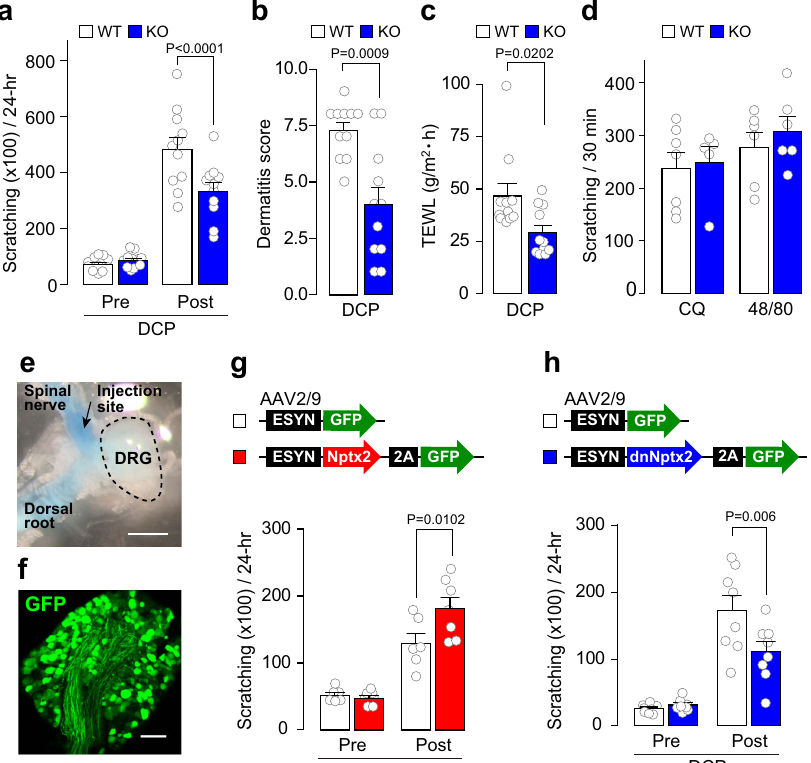
Fig. 4 Role of NPTX2 in chronic itch-like behavior. a Scratching behavior for 24 hr in WT and NPTX2 KO mice before (Pre) and after DCP treatment (Post) ( n = 11 mice/group; two-way repeated-measures ANOVA with post hoc Bonferroni test). b , c Dermatitis score ( c ) and transepidermal water loss (TEWL) ( d ) in DCP-treated WT and NPTX2 KO mice ( n = 11 mice/group). d Scratching bouts induced by intradermal injection of chloroquine (200 μ g) and compound 48/80 (50 μ g) in WT and NPTX2 KO mice (chloroquine: WT, n = 7; KO, n = 5; compound 48/80: WT, n = 6; KO, n = 6). e Photograph of the cervical DRG (C3) removed after the microinjection with AAV-ESYN-GFP including blue dye. Scale bar, 1 mm. f GFP fl uorescence in the cervical DRG (C3) of mice with AAV-ESYN-GFP. Scale bar, 100 μ m. g Scratching behavior by the left hind limb for 24 hr in NPTX2 KO mice with AAV-ESYN-GFP ( n = 6) or AAV-ESYN-NPTX2 ( n = 7) before (Pre) and after DCP treatment to the left back (Post). Two-way repeated-measures ANOVA with post hoc Bonferroni test. h Scratching behavior by the left hind limb for 24 hr in WT mice with AAV-ESYN-GFP ( n = 8) or AAV-ESYN-dnNPTX2 ( n = 8) before (Pre) and after DCP treatment to the left back (Post). Two-way repeated-measures ANOVA with post hoc Bonferroni test. Values represent mean ± S.E.M. Source data are provided as a Source Data fi mice, we injected AAV-ESYN-NPTX2 or -GFP into the spinal reduction in scratching behavior in DCP-treated NPTX2 KO nerves of the left C3/4 DRGs in order to minimize the time and mice was rescued by ectopic expression of NPTX2 in cervical tissue damage related to the operation, and DCP was topically DRG neurons (Fig. 4g). Reciprocally, the DCP-induced scratching applied only to the left side of the back and counted the number behavior in WT mice was signi fi cantly attenuated by expressing of scratching behaviors by the left hind limb. We found that the the dominant-negative form of NPTX2 (dnNPTX2), which